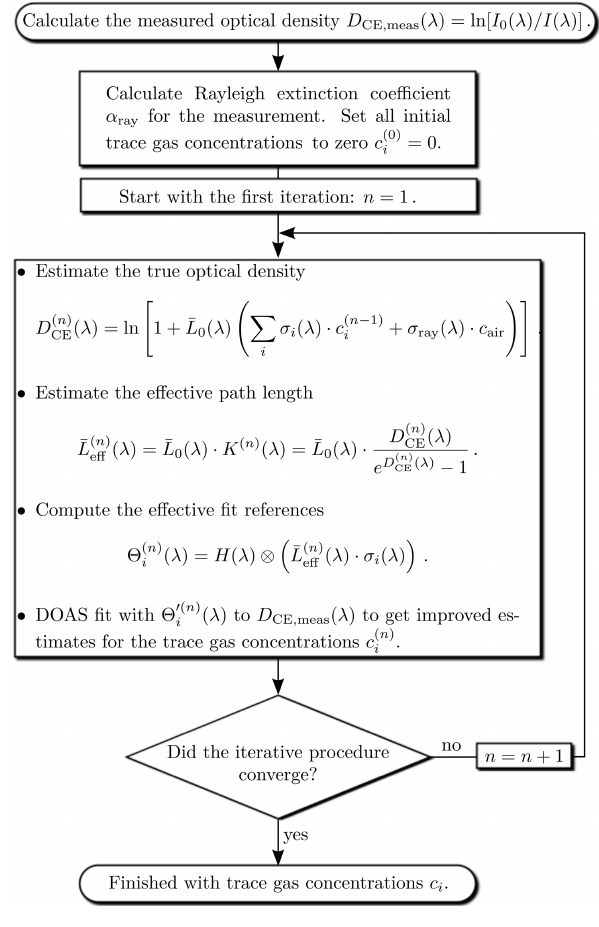
Figure 4. Scheme of the ICAD